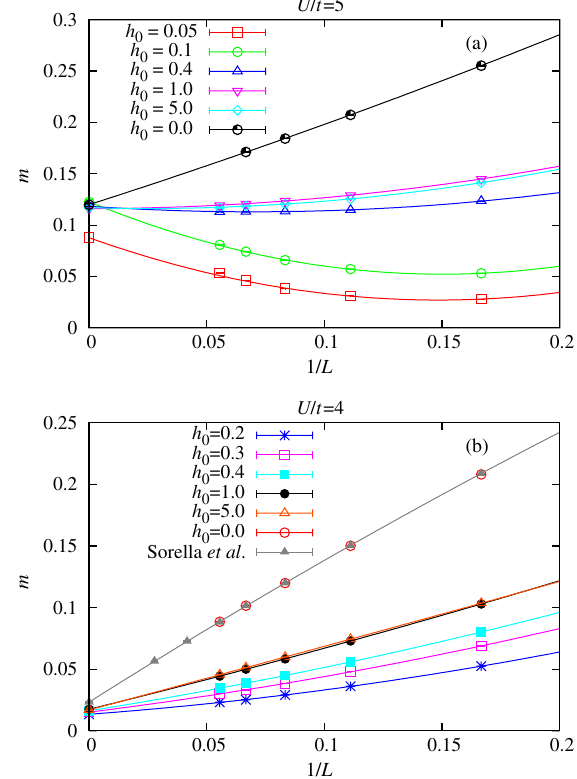
FIG. 1. Comparison of the pinning-field and correlation- function approaches to determine the staggered moment at (a) U=t ¼ 5 and (b) U=t ¼ 4 . The data sets at h 0 ¼ 0 correspond to the correlations functions, and values of (cid:6)t ¼ 40 are sufficient to converge to the ground state. For nonvanishing pinning fields, projection parameters (cid:6)t ¼ 320 are required to guarantee con- vergence. We use (cid:2) (cid:7)t ¼ 0 : 1 , which for the symmetric Trotter decomposition yields converged results within our numerical accuracy. At U=t ¼ 4 , comparison with the results of Ref. [2] shows excellent agreement. Lines corresponds to least-squares fits to the form a þ b=L þ c=L 2